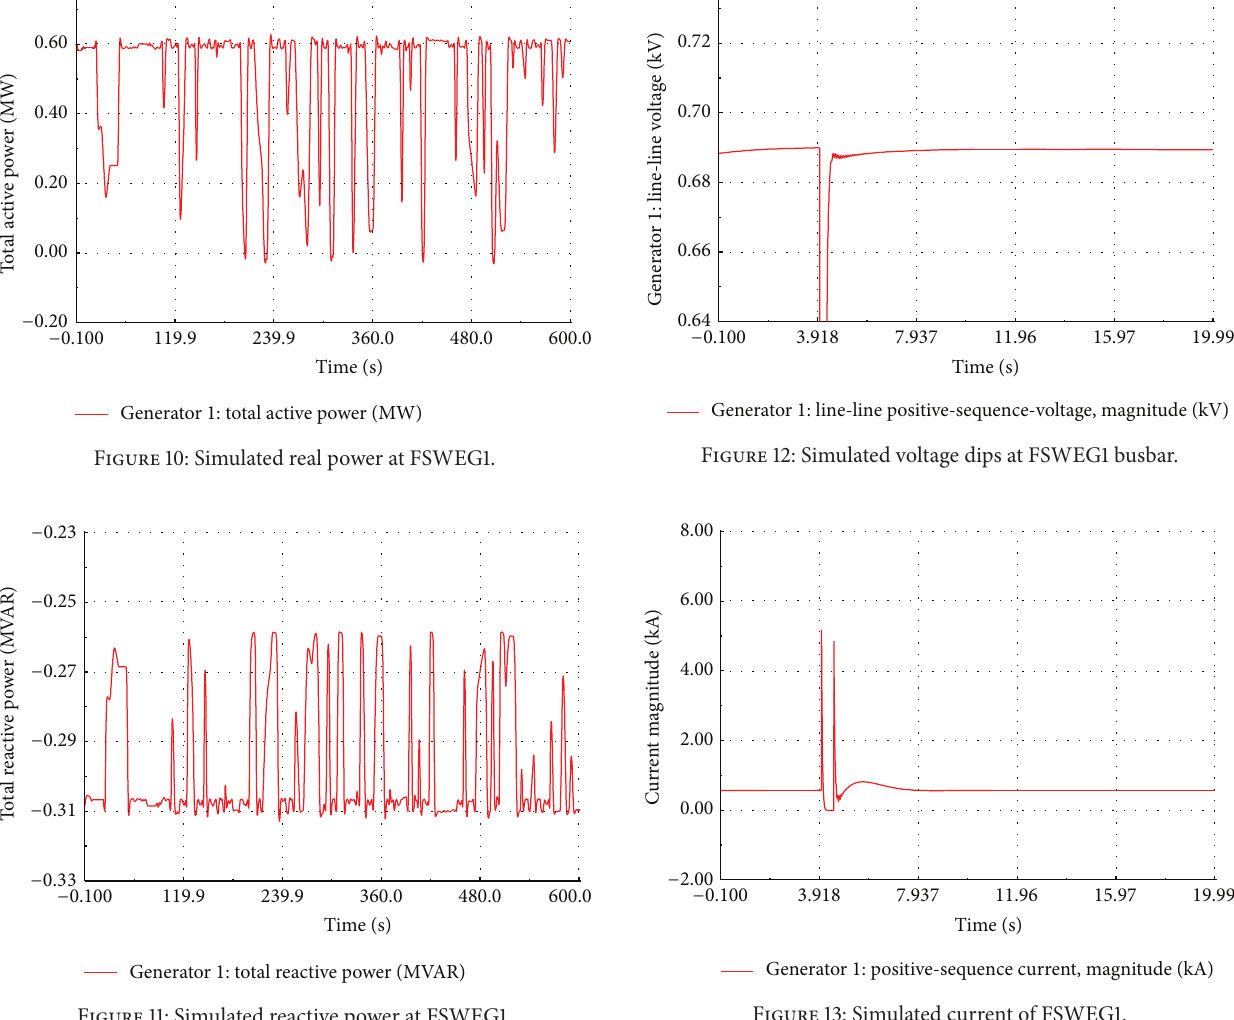
Figure 11: Simulated reactive power at FSWEG1.